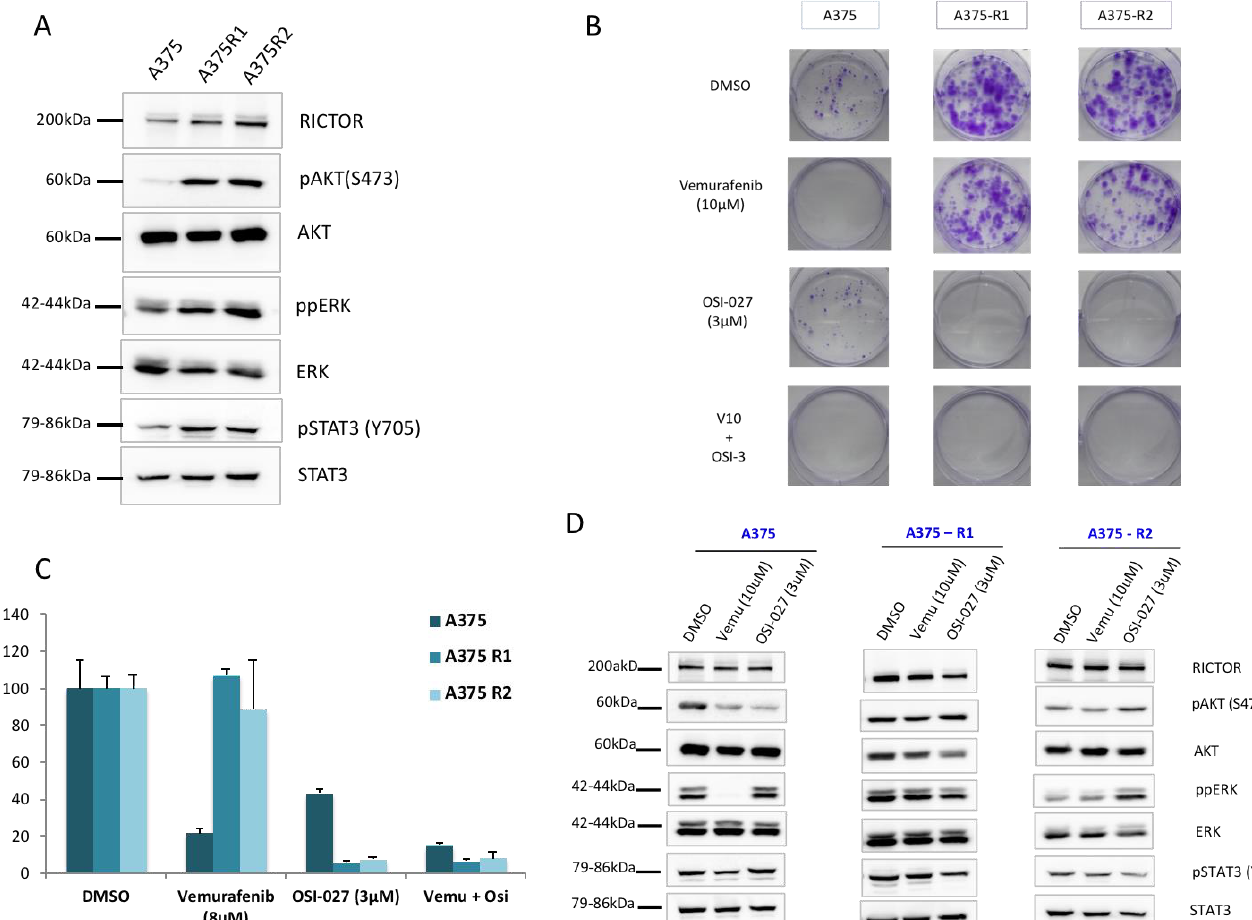
Figure 4. RICTOR overexpression contributes to melanoma-targeted therapy resistance through STAT pathway ( A ) The expression of RICTOR, phosphorylated AKT and ERK, total AKT and ERK, phosphorylated STAT3 (Y705), and total STAT3 were assessed by Western blotting in the A375 melanoma cell line and two independent clones of A375 Vemurafenib resistant to vemurafenib (A375R1 and A375R2). ( B , C ) A375 parental and resistant cell lines cells were seeded at low density and treated three times a week with inhibitors or DMSO, Vemurafenib (10 µ M), OSI-027 (3 µ M), or the combination of both for 10 days. Graphs represent the mean ± s.d. of an experiment in triplicate (similar results were obtained in three independent experiments). ( D ) A375 parental and resistant cell lines cells were treated for 24 h with DMSO, Vemurafenib (10 µ M), or OSI-027 (3 µ M), and the expressions of RICTOR, phosphorylated AKT and ERK, total AKT and ERK, phosphorylated STAT3 (Y705), and total STAT3 were assessed by Western blotting.